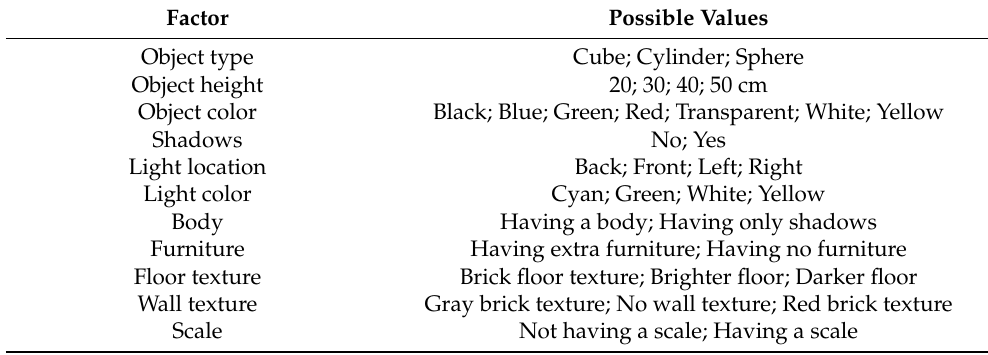
Table 1. Factors and their possible